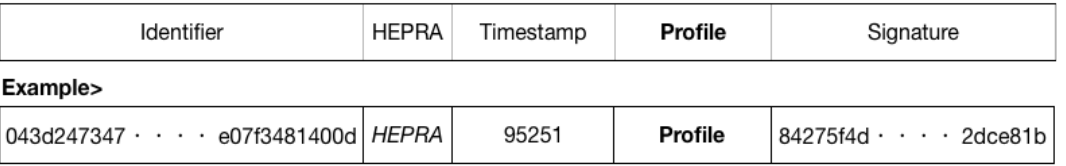
Figure 3. HEPR Acknowledgement message format and example.